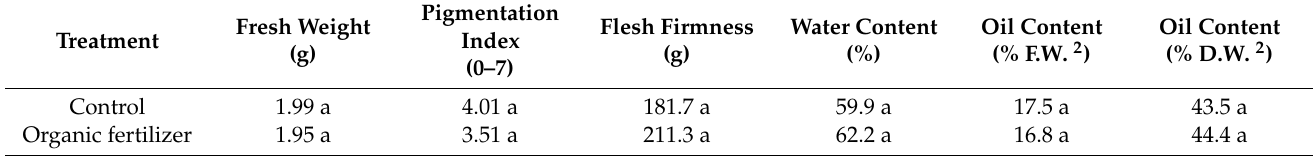
Table 2. Fruit characteristics at harvest of treated (organic fertilizer) and control (chemical fertilizer) trees in the field 1 .